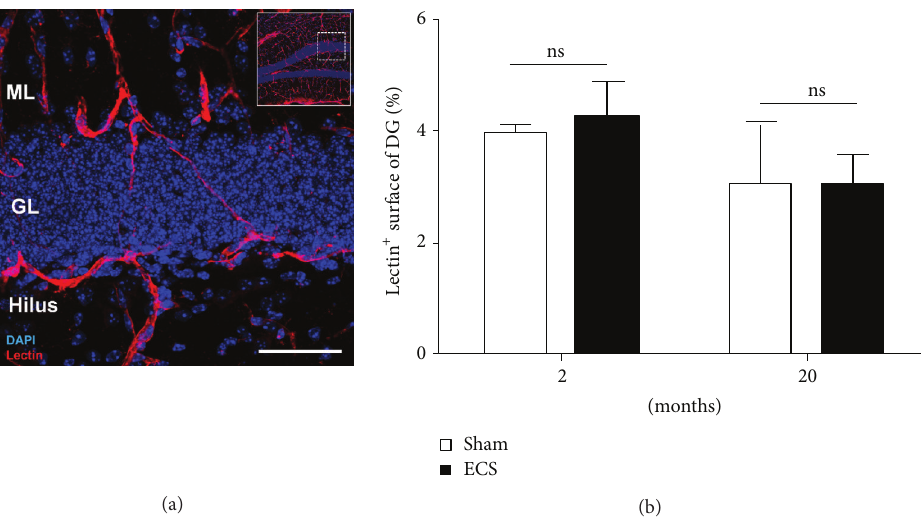
Figure 5: (a) Detection of blood vessels in the granular layer of the dorsal dentate gyrus with B. simplicifolia lectin (red) (inset, overview of the dentate gyrus with position of the field of view, ML: molecular layer, GL: granular layer). Scale bar: 50 𝜇 m. (b) No significant differences in blood vessel density could be detected following ECS. Interestingly, aged brains had a slightly decreased vessel density compared to the younger group ( 𝑃 = 0.0122